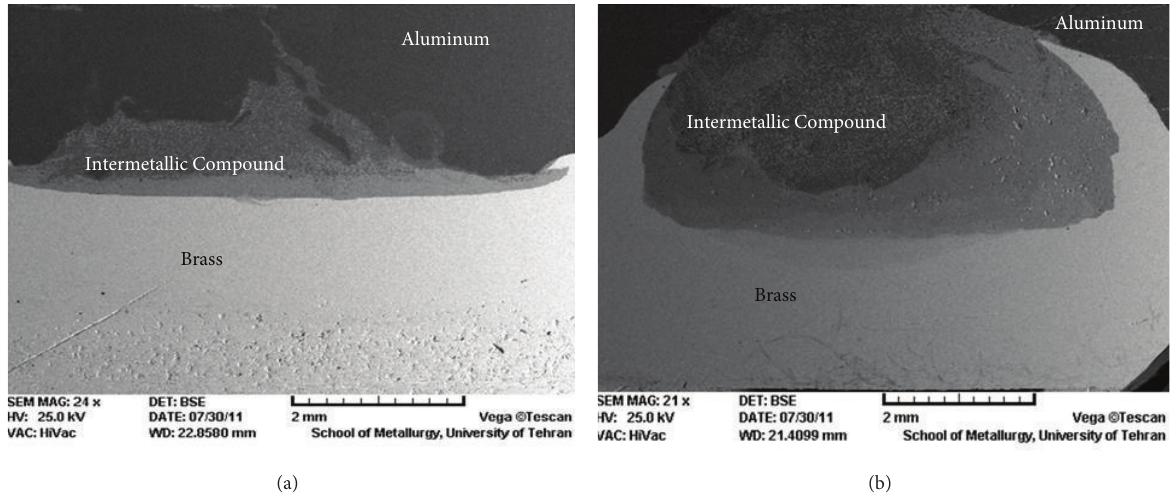
Figure 3: SEM images of the weld zone under various conditions: (a) 900rpm, 6.5 mm/min; (b) 1400rpm, 6.5 mm/min.